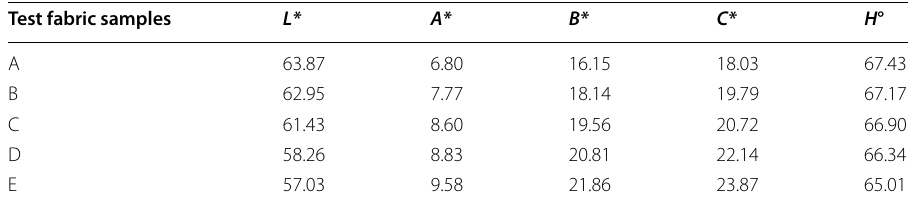
Table 2 Spectrophotometer characterization of henna dyed polyester fabric samples at different temperatures